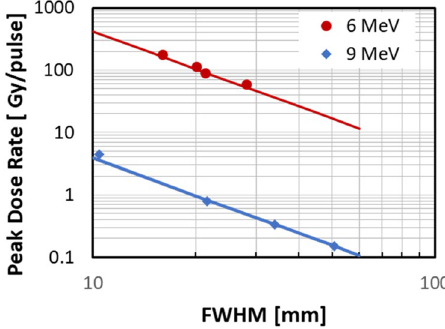
Figure 12. Peak dose rate vs Full Width at Half Max (FWHM) in FLASH and SuperFLASH modes. Reprinted from 33 with permission from